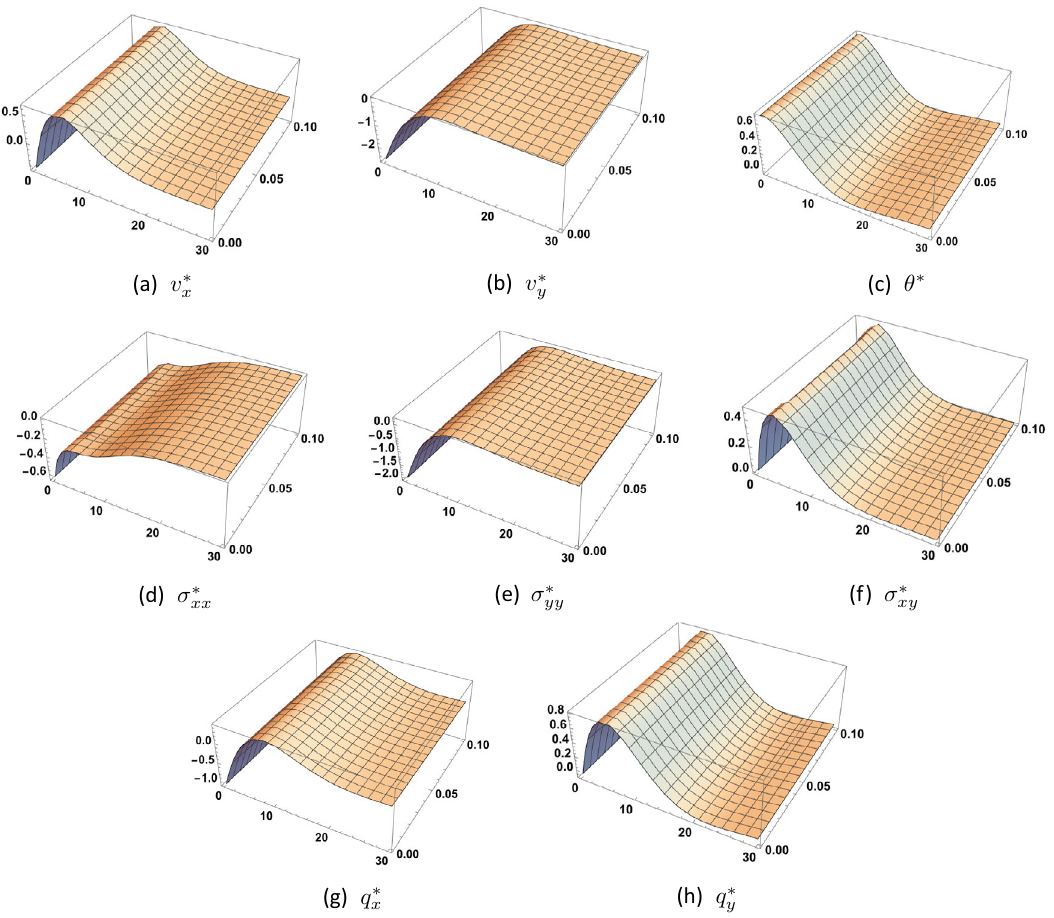
Figure 2. First order solution as function of ( x , y ) at t = 1.5 and for τ q = 0.6 , τ θ = 0.5